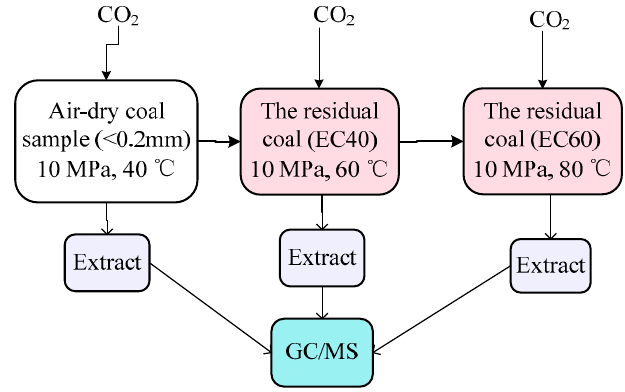
Figure 2. Simplified diagram of the experimental procedure.